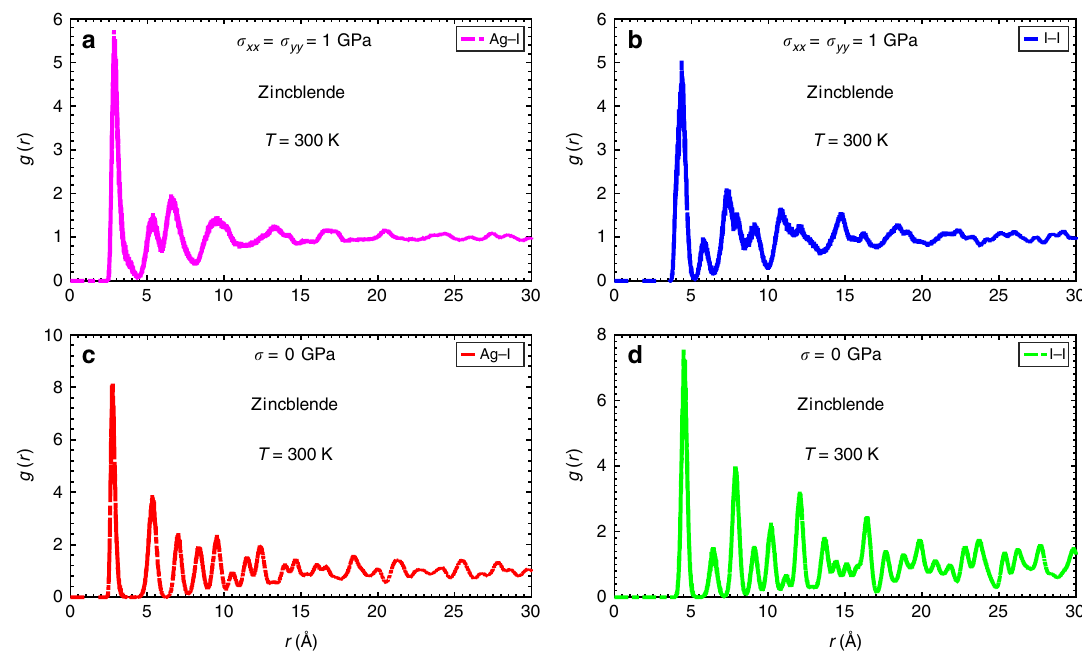
Fig. 6 Ionic radial pair distribution functions in AgI thin fi lms with the zincblende ( γ ) structure at T = 300 K. Results are expressed as a function of ionic pairs and biaxial compressive stress. a Ag-I and σ xx = σ yy = +1 GPa; b I-I and σ xx = σ yy = +1 GPa; c Ag-I and σ xx = σ yy = 0 GPa; d I-I and σ xx = σ yy = 0 GPa